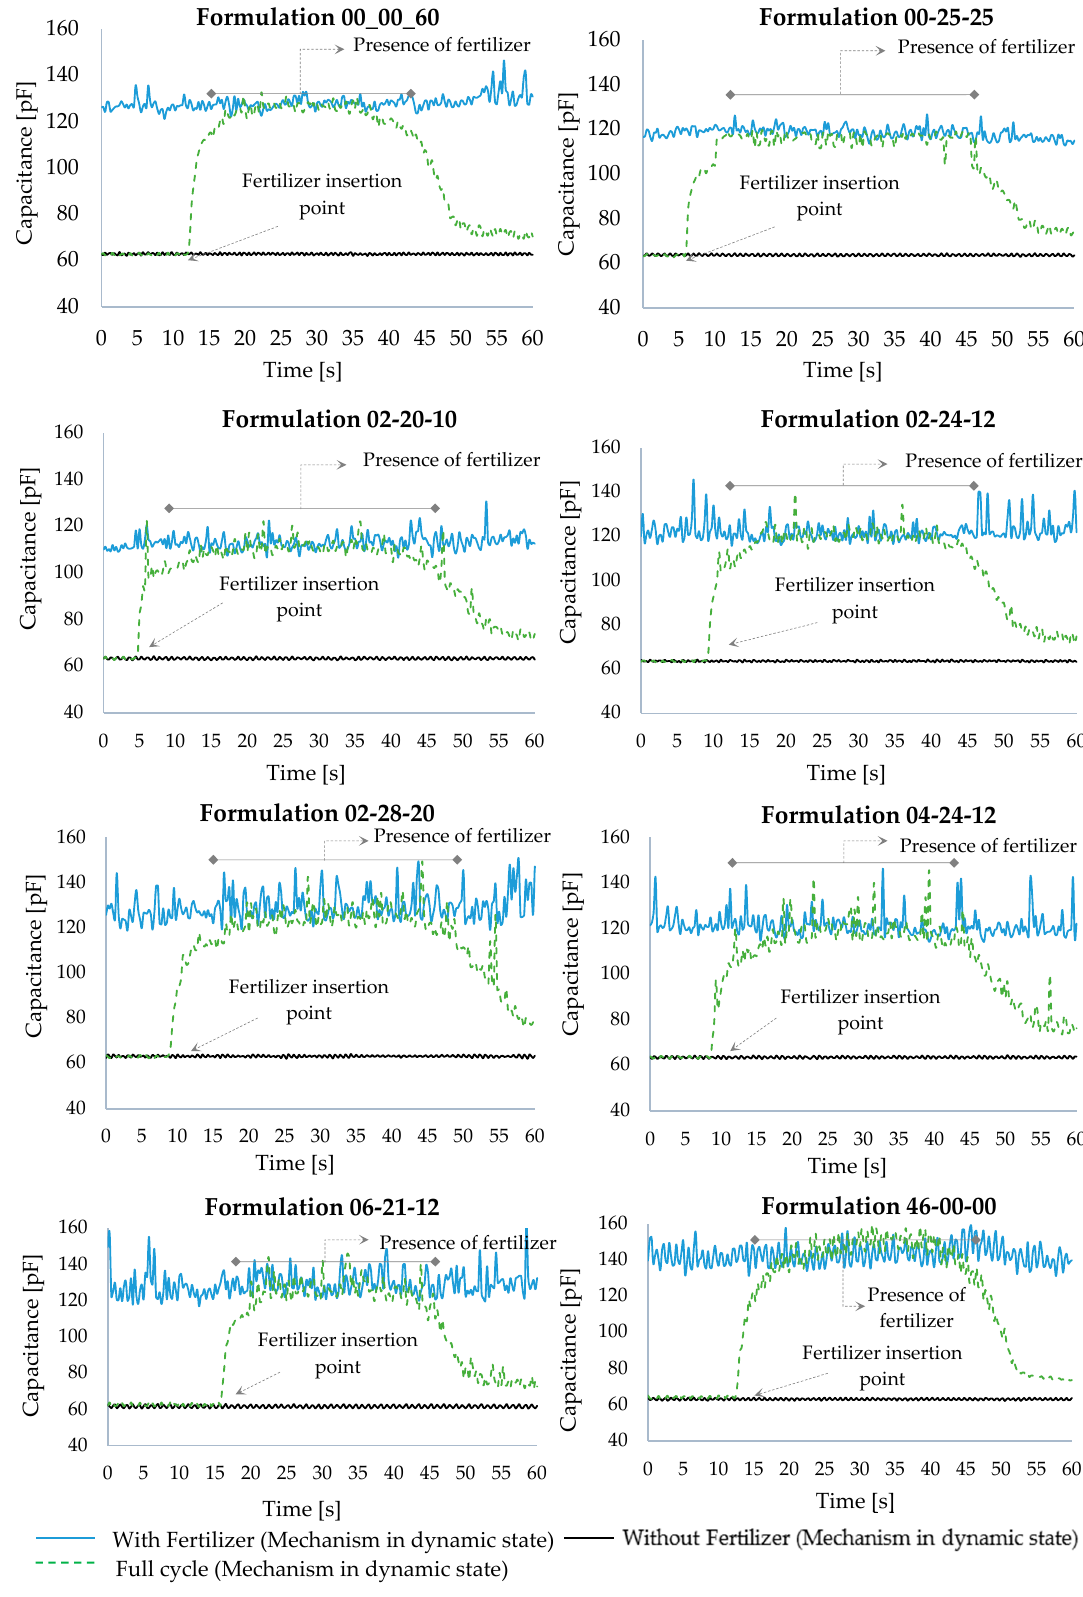
Figure 6. Graphs of the sensor response simulating the fertilizer distribution full cycle.